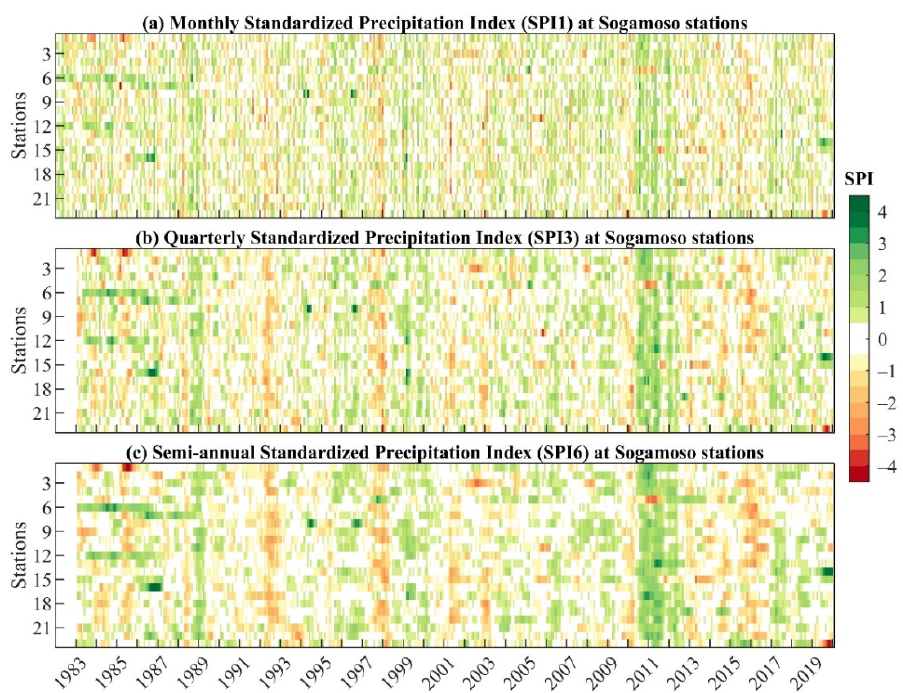
Figure 2. Temporal evolution of ( a ) monthly standardized precipitation index (SPI1), ( b ) quarterly- SPI3, and ( c ) semiannual SPI6 in the Sogamoso River Basin (SRB) stations during the 1982–2019 period. For ( b , c ) the first 12 months are lost in the calculation of the SPI3 and SPI6.